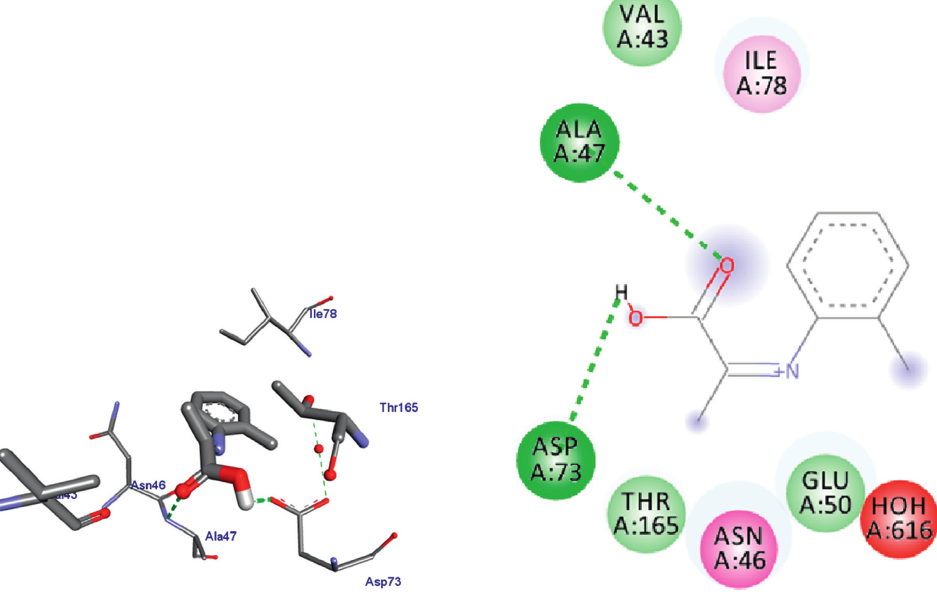
Figure 8: The binding interactions of 15 against E. coli DNA gyrase A (PDB ID: